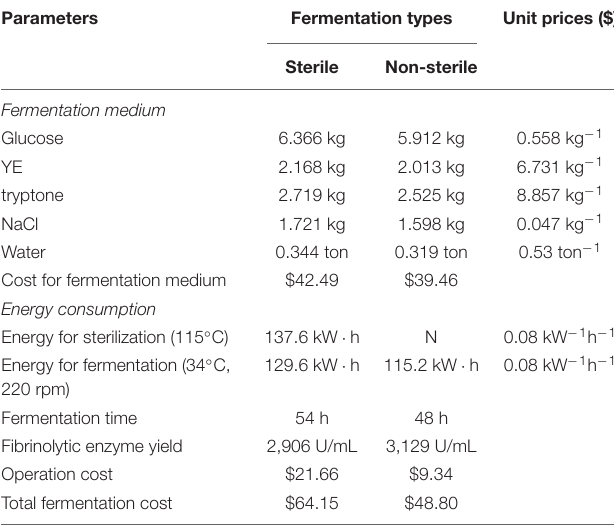
TABLE 4 | Comparison of cost between sterile and non-sterile fermentation with the optimized medium to produce 1 × 10 9 U fibrinolytic enzyme.